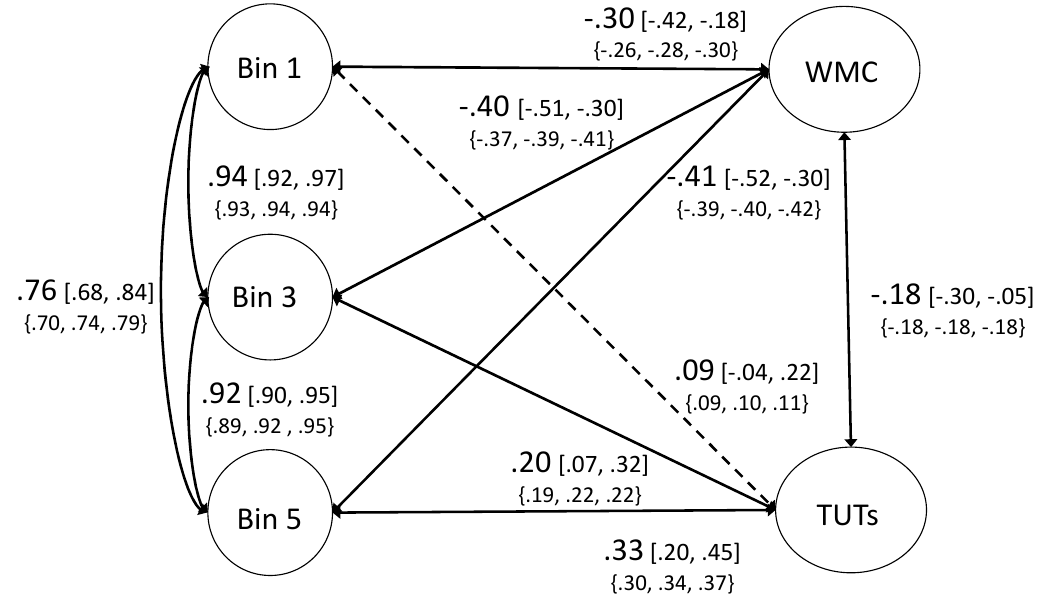
Figure 1. Confirmatory factor analysis of ranked-bin models. WMC = working memory capacity. TUTs = task-unrelated thoughts. Path estimates are presented in largest size font. The 95% confidence intervals are presented in brackets. Values in the braces below represent the lowest, median, and highest estimate from the mini multiverse analysis (see Section 3.3). For clarity, factor loadings are not presented here; see Supplemental Table S3 for factor loadings for all models included in the primary analyses.